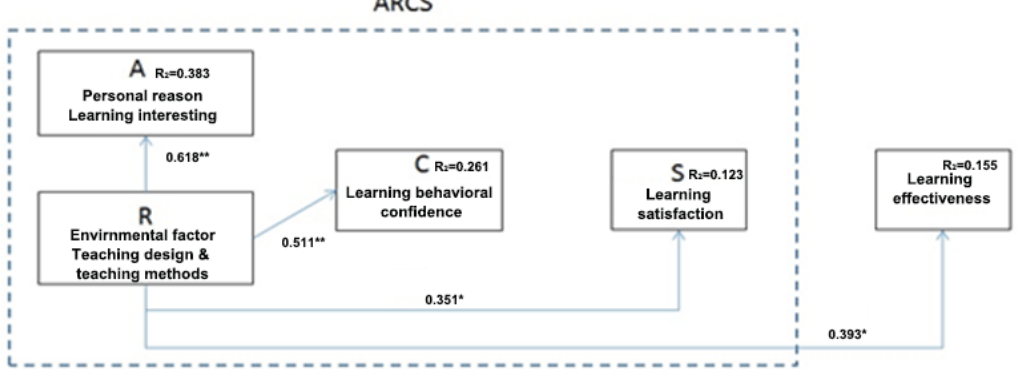
Figure 7. Overall regression analysis of this study. The results of the regression analysis of this study are shown through arrows between the di ff erent factors. If the regression analysis following an arrow is of significance, the normalized coe ffi cient data will have an asterisk (*). This indicates that the causal relationship has a direct e ff ect, which can be confirmed by the letter. Otherwise, if the normalized coe ffi cient data is not significant, there will be no asterisk, indicating that there is no direct e ff ect, and the arrow segment does not